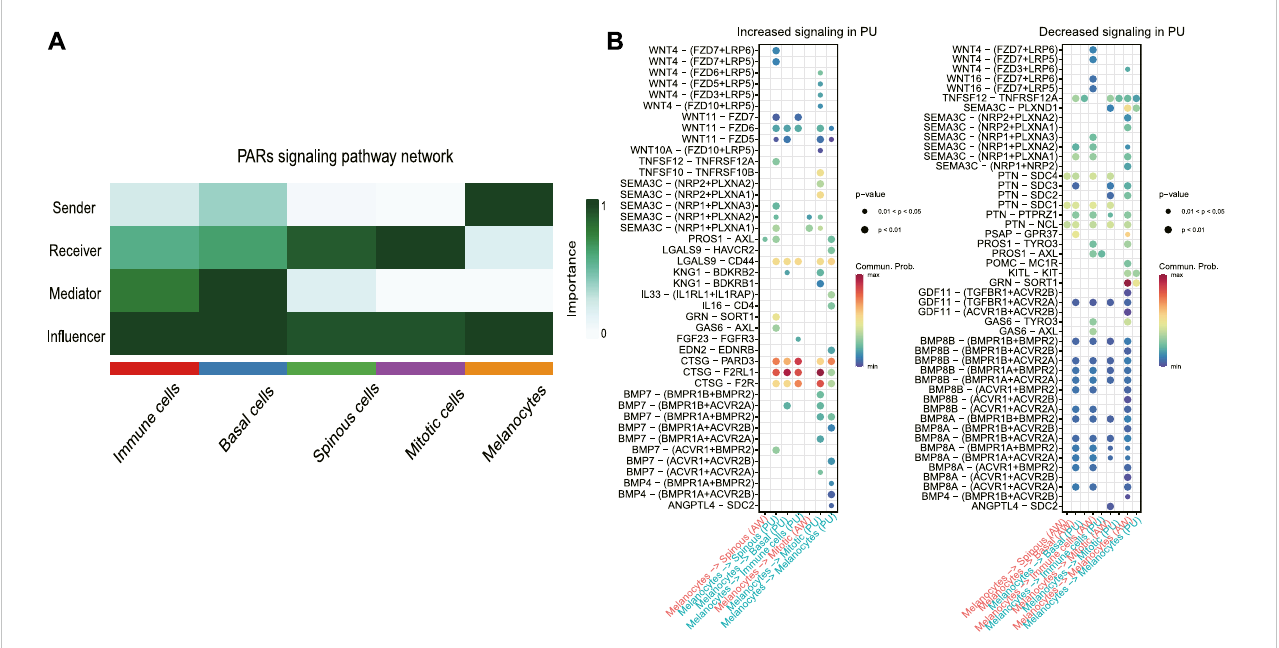
FIGURE 4 The melanocyte cell population wasthedominant sender ofthePARs signaling pathway. (A) ,Dominant senders,receivers,mediators,andin fl uencers of PARs signaling pathways. (B) , the upregulated (increased) and downregulated (decreased) signaling ligand-receptor pairs in PU compared to AW. The increased signaling means these pathways have a higher communication probability (strength) in PU compared to AW. AW: acute wounds; PU: pressure